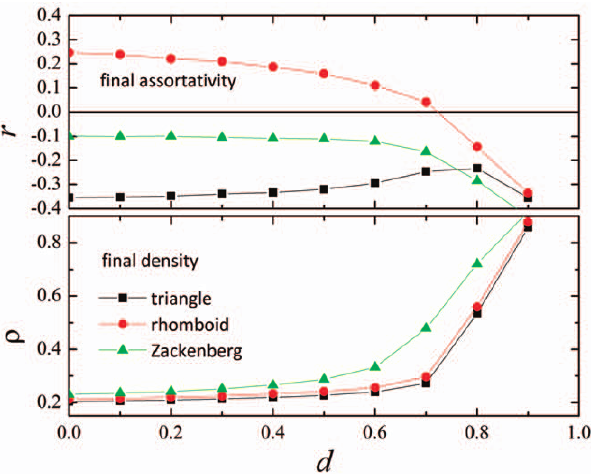
Figure 5. Final network properties as a function of the destruction parameter. Average of 1000 realizations for triangle and rhomboid models and for Zackenberg network. All with initial density of links 0 : 18 . (Note that the density of links after the disruption is the number of existing links divided by the total number of possible links between the extant species.).